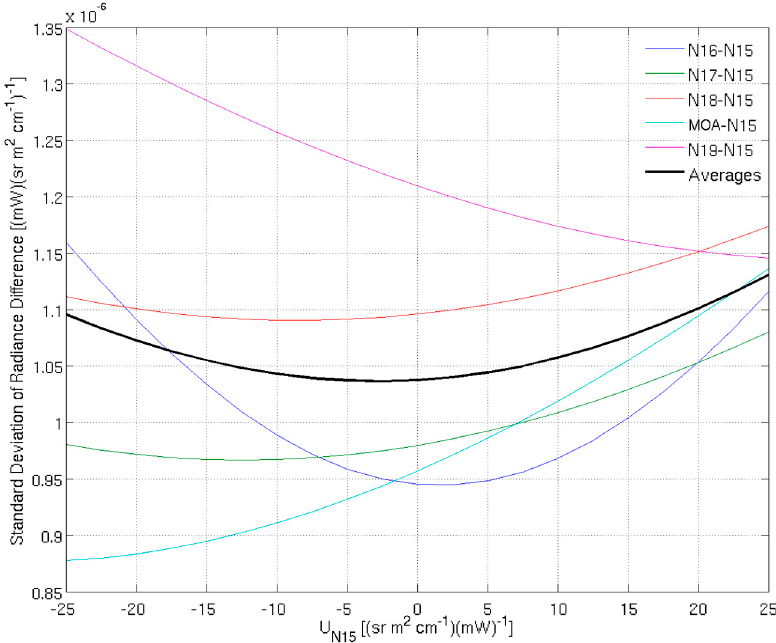
Figure 5. Iterative search for µ N 15 of 23.8 GHz channel. The average line is the major criterion to select the optimal µ N 15 .